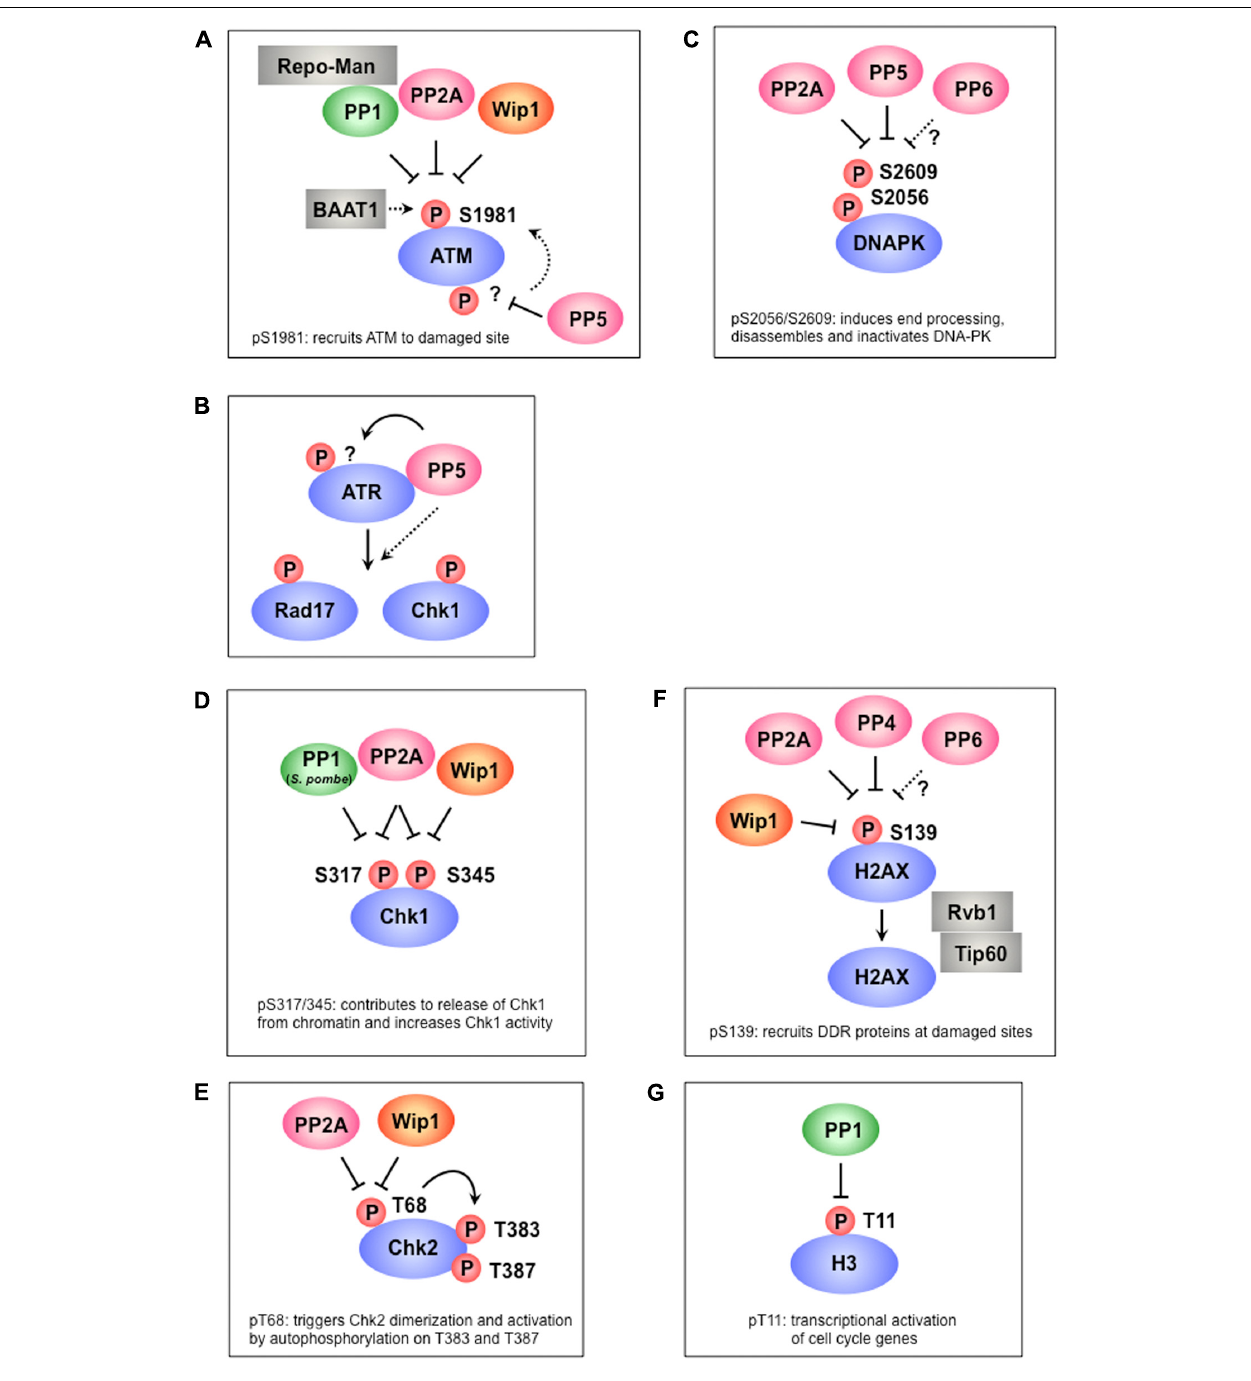
precise mechanism remains to be determined. (C) PP2A, PP5, and possibly PP6 dephosphorylate multiple sites on DNA-PK, including S2056 and S2609. These sites are autophosphorylated by DNA-PK and are involved in the activation/inactivation of DNA-PK. (D) PP1 ( S. pombe ), PP2A, andWip1 dephosphorylate Chk1 at S317 and/or S345, which promotes its release from chromatin and increases Chk1 kinase activity. (E) PP2A andWip1 mediate the dephosphorylation of Chk2 atT68, which facilitates Chk2 dimerization and